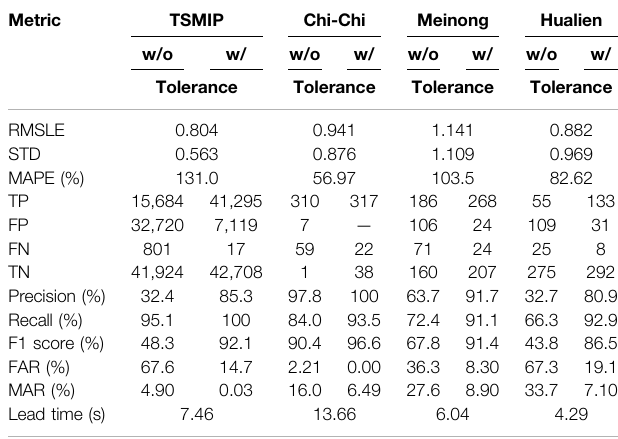
TABLE 3 | The performance metrics of the TSMIP, Chi-Chi earthquake, Meinong earthquake, and Hualien earthquake data sets using the proposed LSTM